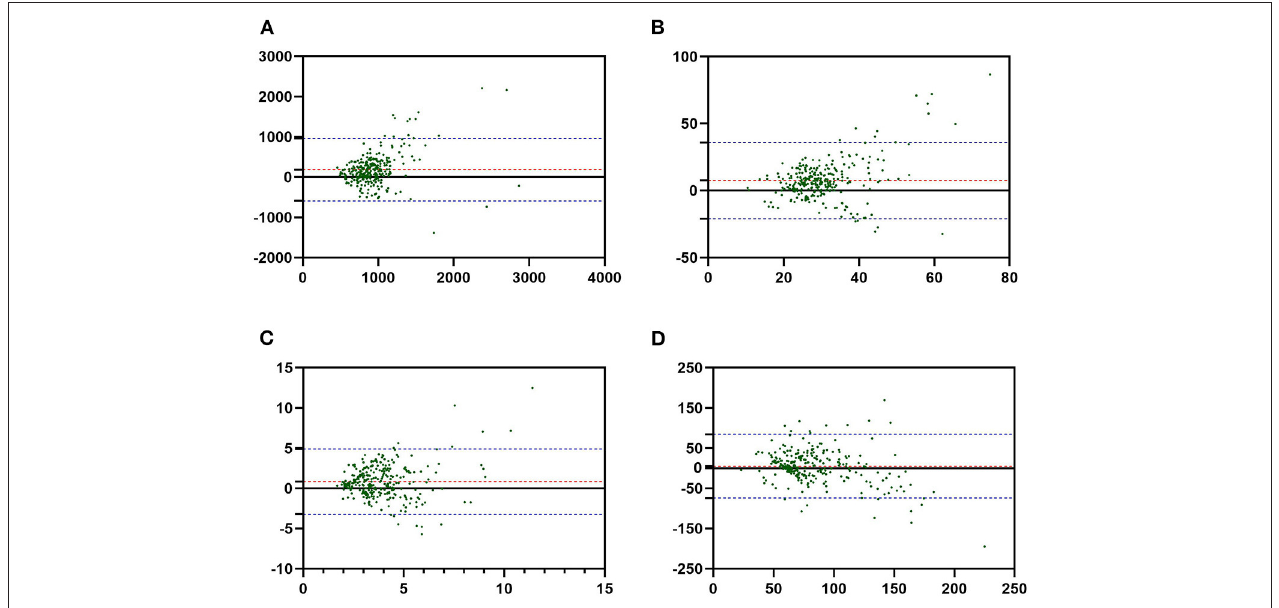
FIGURE 3 | The Bland–Altman plots for energy and select nutrients. (A) Energy, (B) protein, (C) dietary fiber, (D) iron. The average intakes from both the food frequency questionnaire 1 (FFQ1) and 3-day 24-h diet recall record (3R24) are plotted on the X -axis, and the difference is plotted on the Y -axis. The red line means the mean of difference. Two blue lines mean the limits of agreement (LOA), defined as mean difference ± 1.96 × SD. The green points mean dietary intakes data of